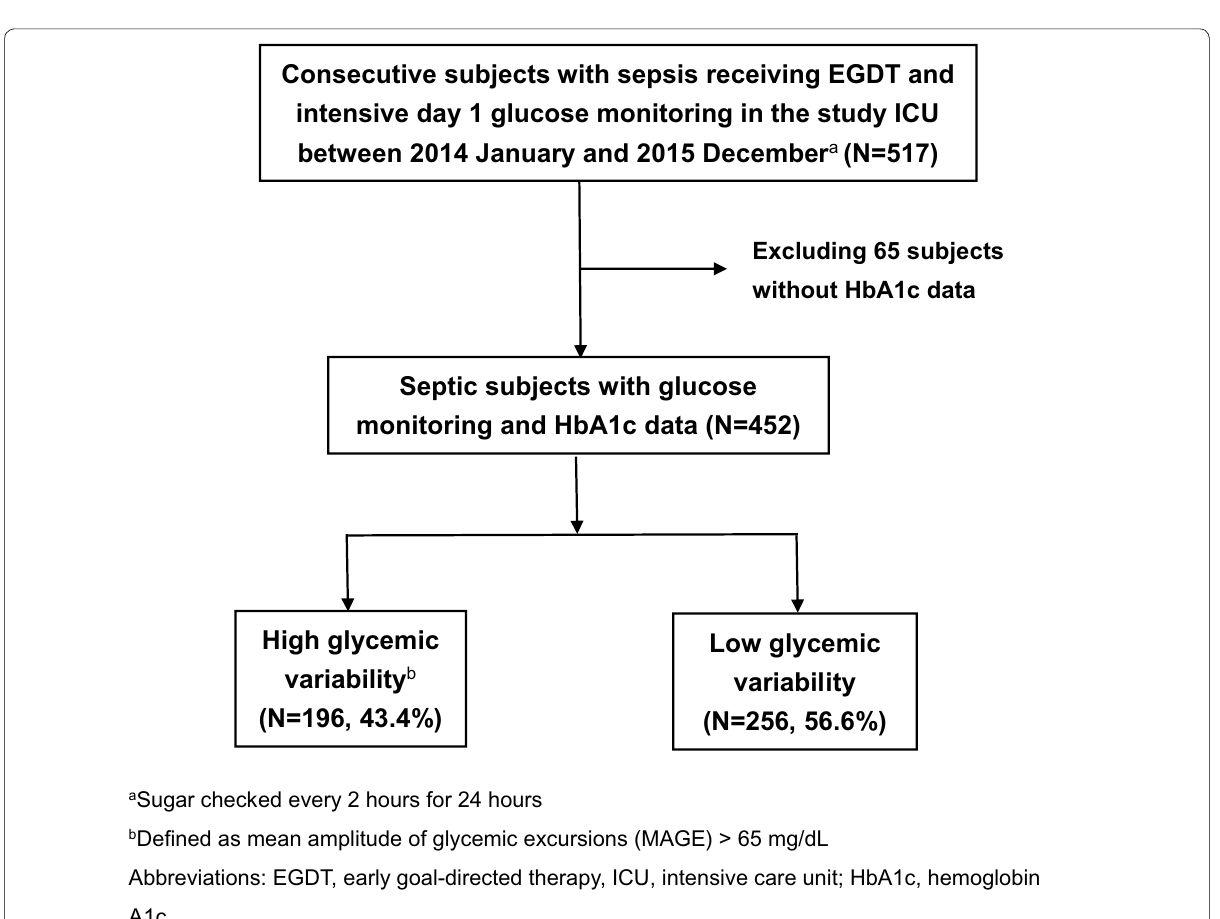
Fig. 1 Flowchart of patient